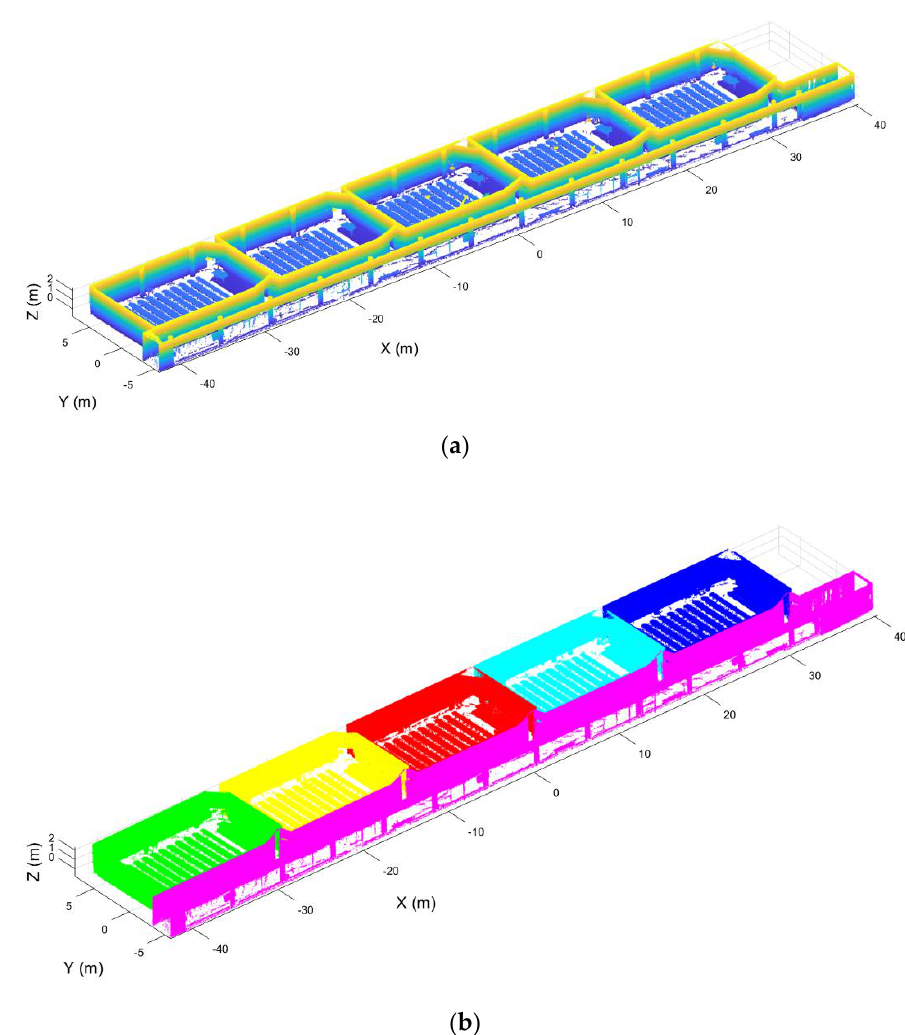
Figure 6. Point clouds without ceiling and floor segmented into rooms. ( a ) Initial point cloud, colored by height, before the segmentation. ( b ) Final point cloud labeled by rooms, each room with a different color.